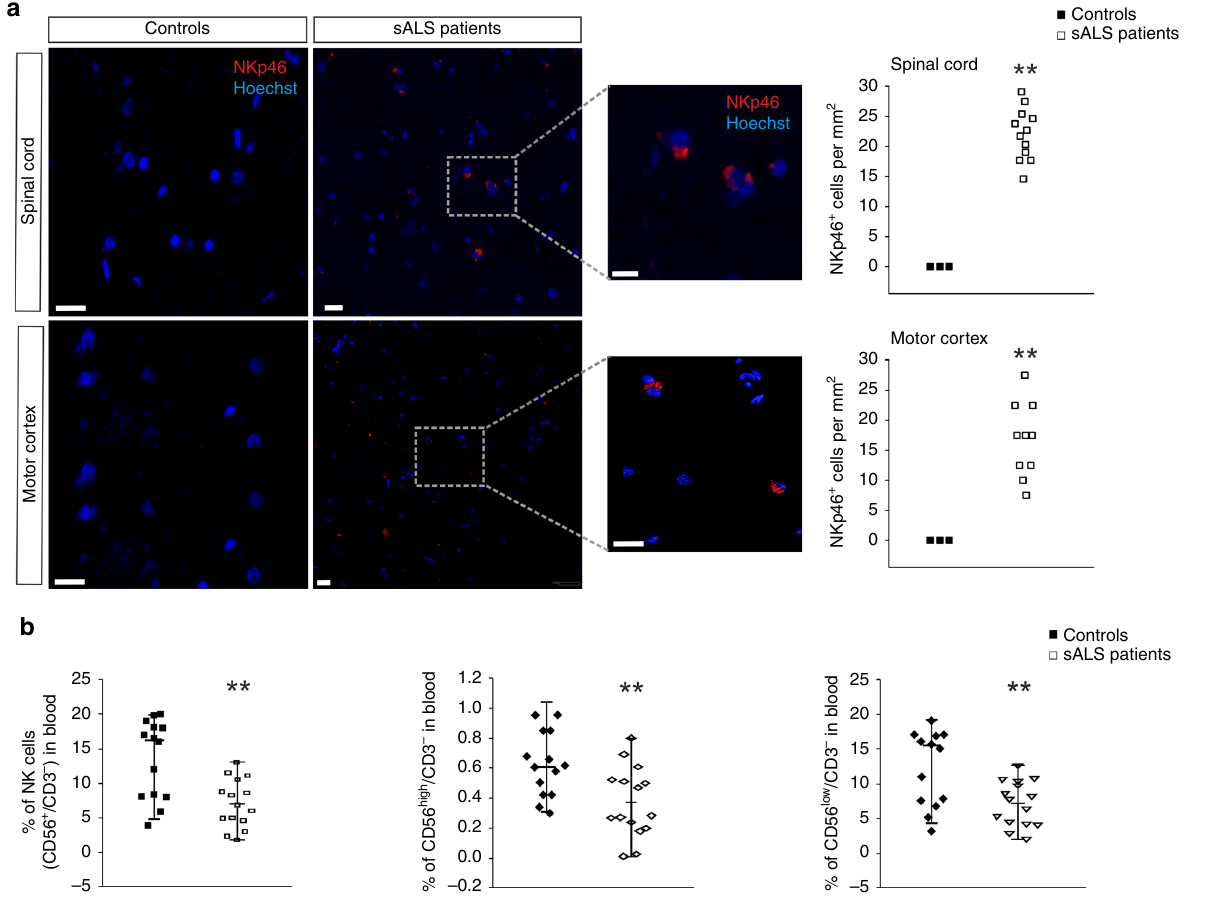
Fig. 1 NK cells in fi ltrate the CNS affected regions in ALS patients. a NKp46 + cells (in red) in slices of the spinal cord and motor cortex obtained from sALS patients, not present in control patients. 3d reconstruction of one representative NK cell on the right. Scale bar: 20 μ m. ( n = 8 controls, 12 sALS patients ** P <0.01 power 0.999 two-tailed Student ’ s t -test). Each dot represents the number of NKp46 + cells per patient. Only 3 representative black squares are reported in the graph for Controls, in which were no detected NK cells. b Percentage of CD56 + /high/low /CD3 − cells obtained from peripheral blood of control or sALS patients ( n = 14 controls, 15 sALS patients. ** P < 0.01 power 0.860 two-tailed Student ’ s t -test). Each dot represents the % of NK cells per patient. Error bars show mean± SEM. Source data are provided as a Source Data fi